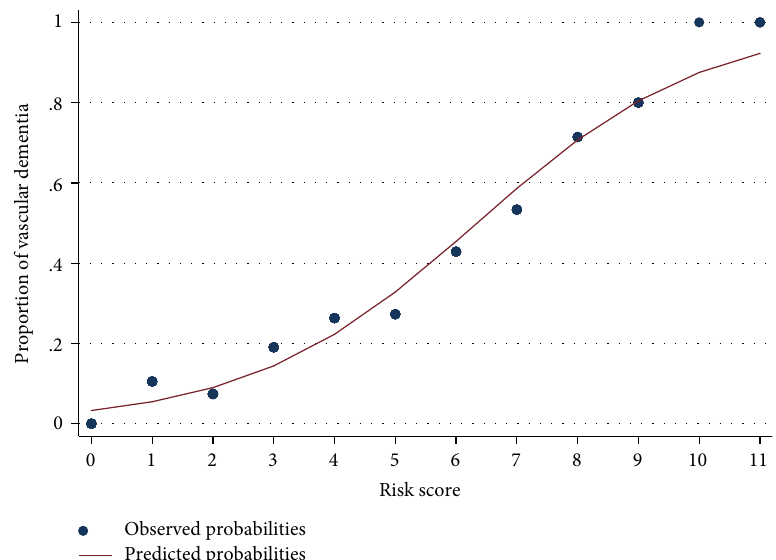
Figure 1: Calibration graphs plotting the predicted probabilities of the risk score (solid line) against the observed probabilities (scatter plot) of vascular